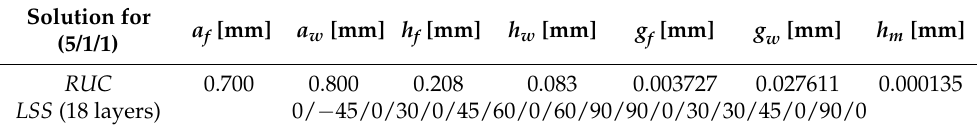
Table 7. The best solution found with satin 5/1/1 fabric as reinforcement.